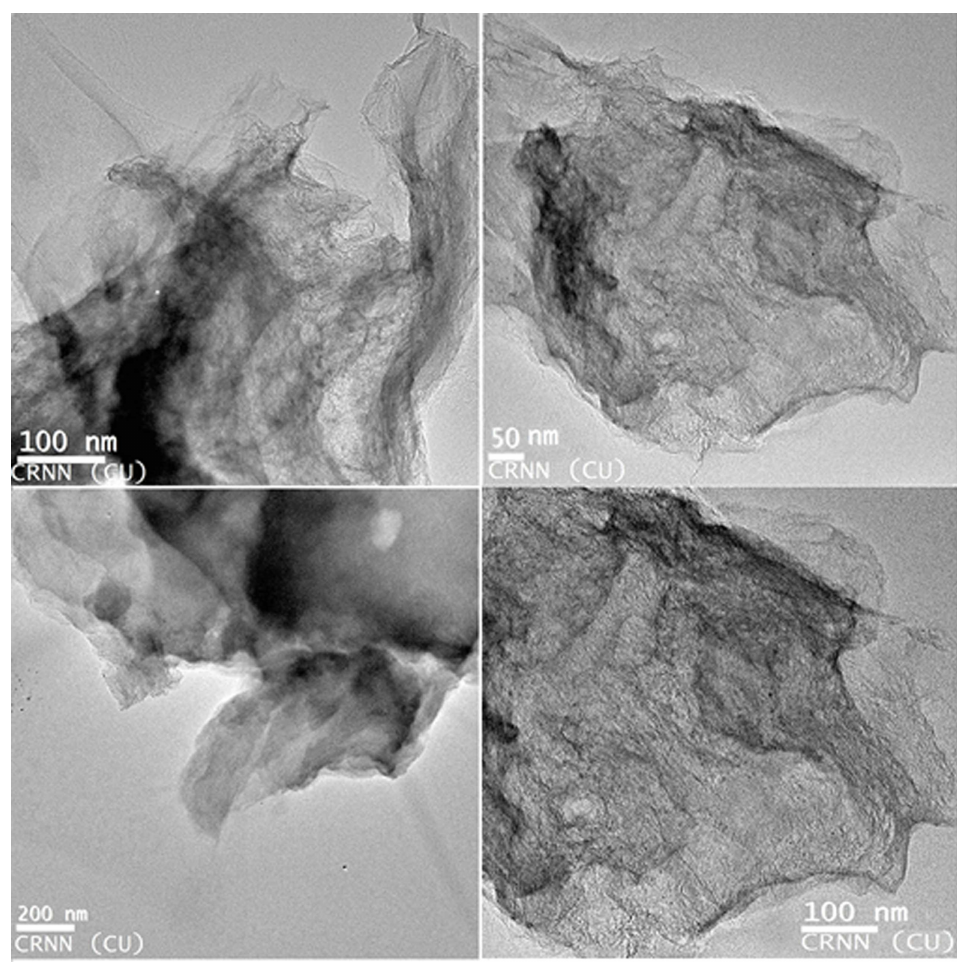
Fig 4. TEM image of